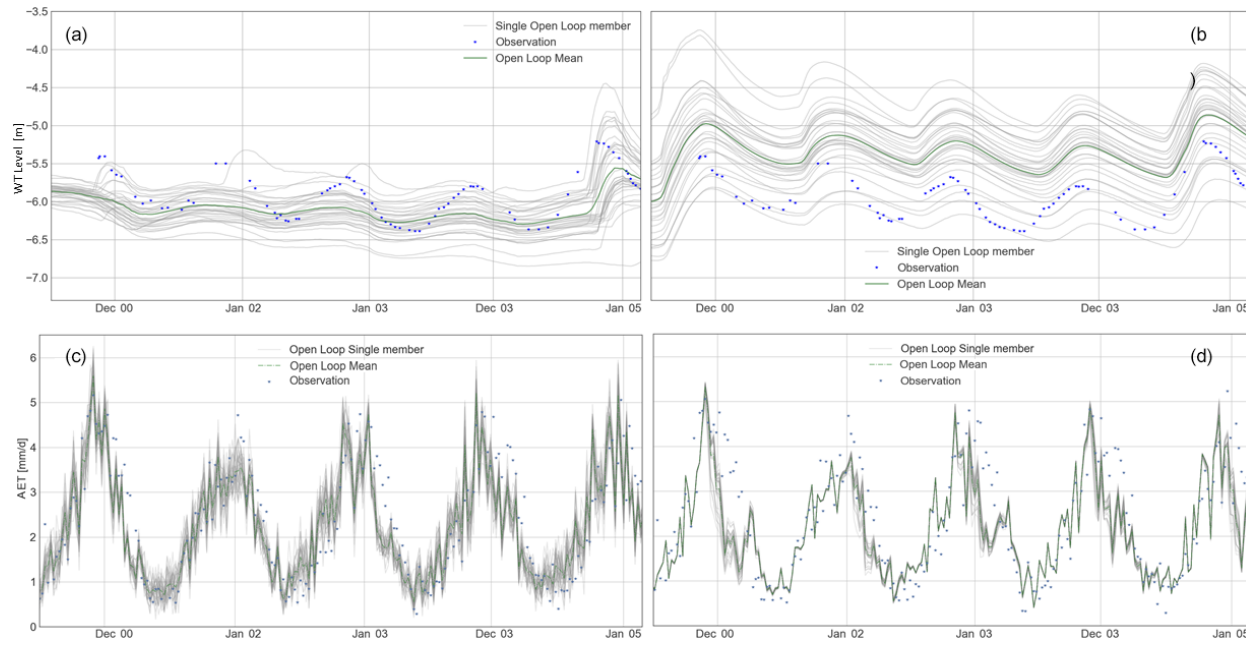
Figure 6. WT levels and AET and spread of the open-loop ensembles for Configuration-1 (a, c) and Configuration-2 (b, d) .